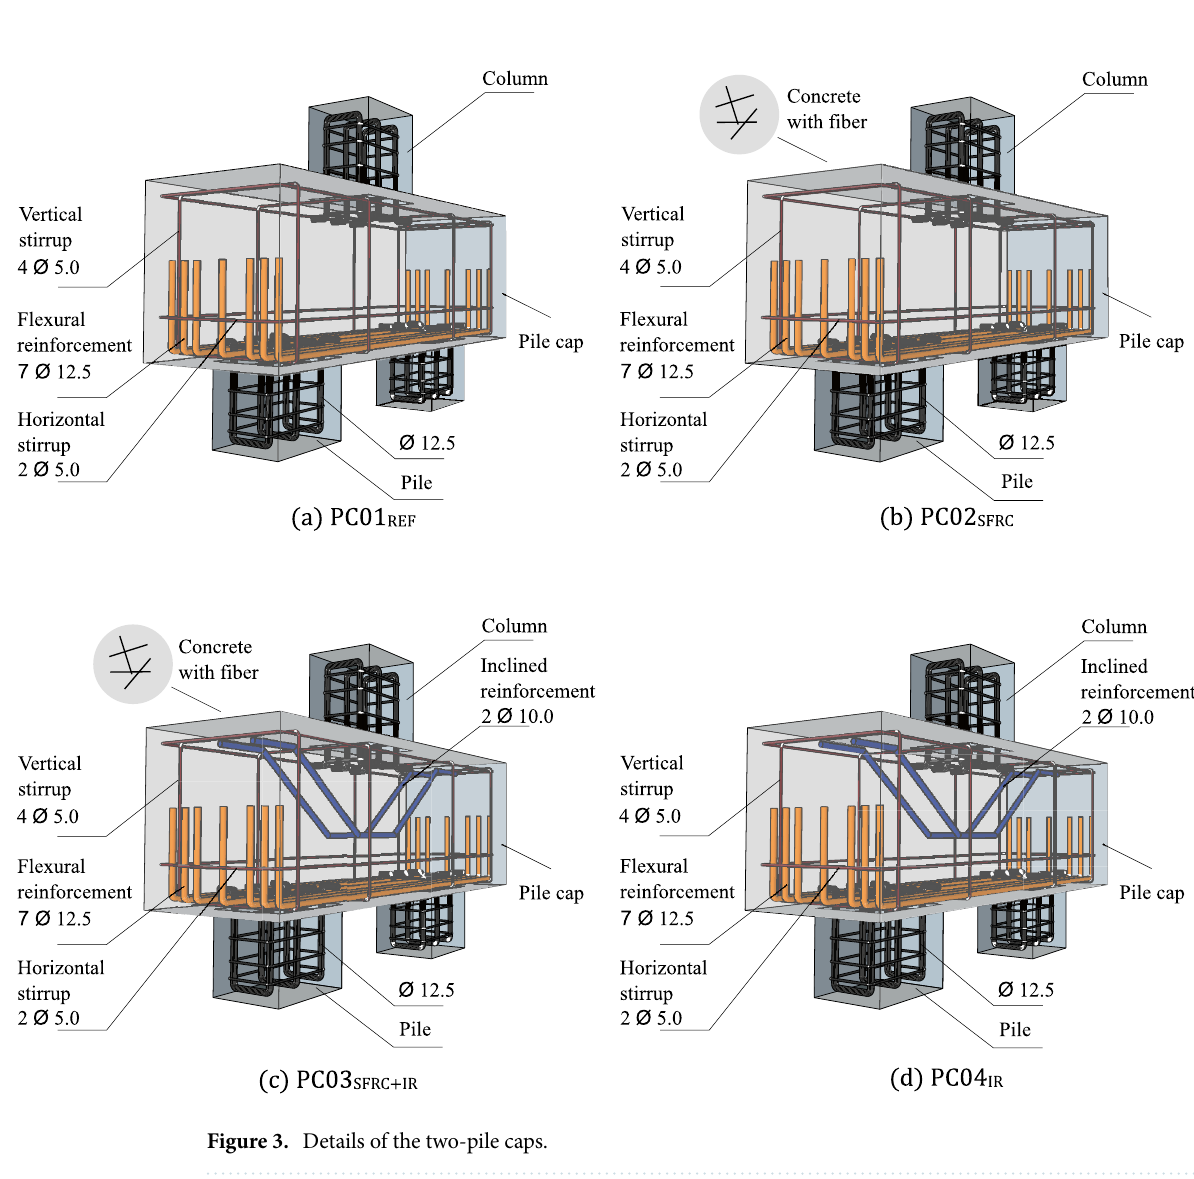
Figure 3. Details of the two-pile